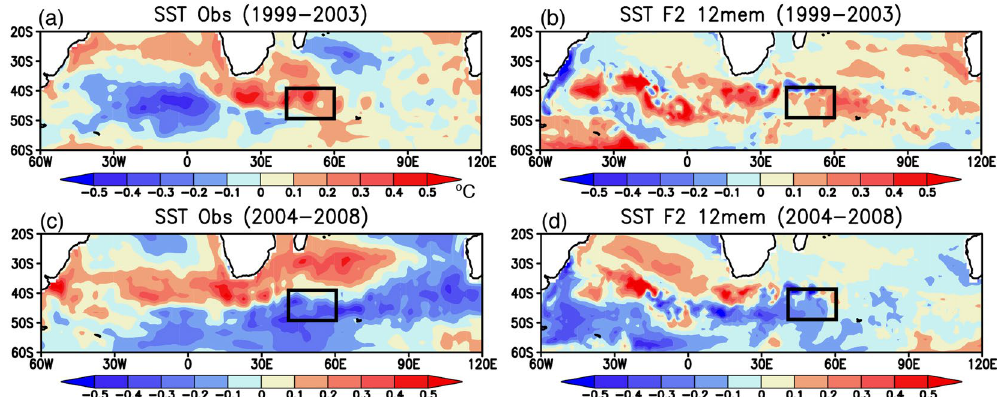
Figure 6. ( a , c ) 5-yr mean SST anomalies (in °C) observed during 1999–2003 and 2004–2008, respectively. The black boxes correspond to the region where the SWIO index was calculated. ( b , d ) Same as in ( a , c ), but for the reforecast experiments initialized from March 1st 1999. Here we show 12 ensemble mean SST anomalies. The maps were generated using Grid Analysis and Display System (GrADS) Version 2.1.a3 (http://cola.gmu.edu/ grads/downloads.php).